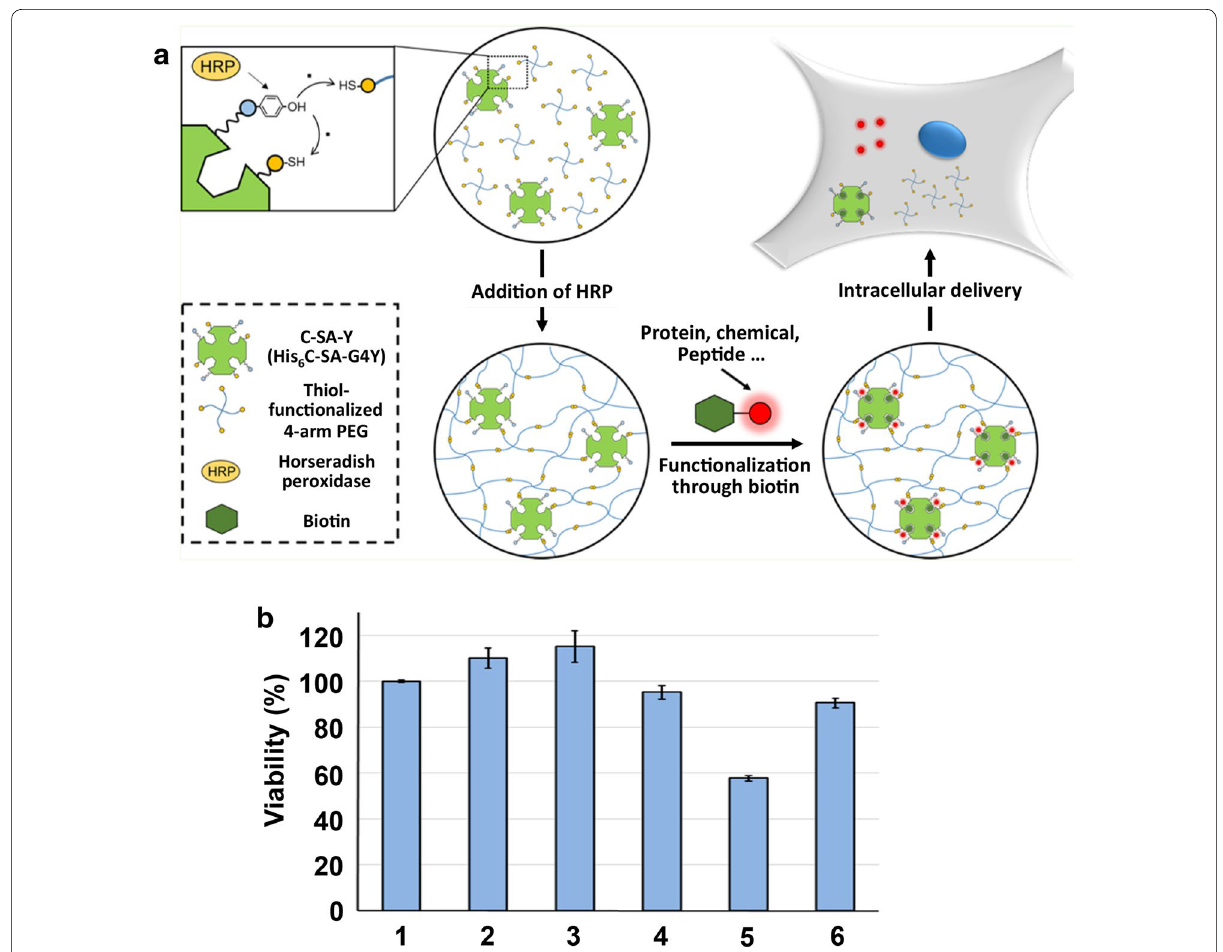
Fig. 6 Peptide tag-induced HRP-mediated preparation of a streptavidin-immobilized redox-sensitive hydrogel. a Schematic illustration of HRP- mediated preparation of a streptavidin-immobilized redox-sensitive hydrogel and intracellular delivery. b Cytotoxicity assay of DLD1 cells incubated with C-SA-Y nanogel functionalized with CPP and saporin. The viability of cells without any treatment was set as 100%. Cells without any treatment ( 1 ) and treated with C-SA-Y nanogel ( 2 ), C-SA-Y nanogel with CPP ( 3 ), C-SA-Y nanogel with saporin ( 4 ), C-SA-Y nanogel with CPP and saporin ( 5 ), and saporin ( 6 ) (Figure reproduced with permission from Ref. [63]. Copyright (2016) with permission from American Chemical